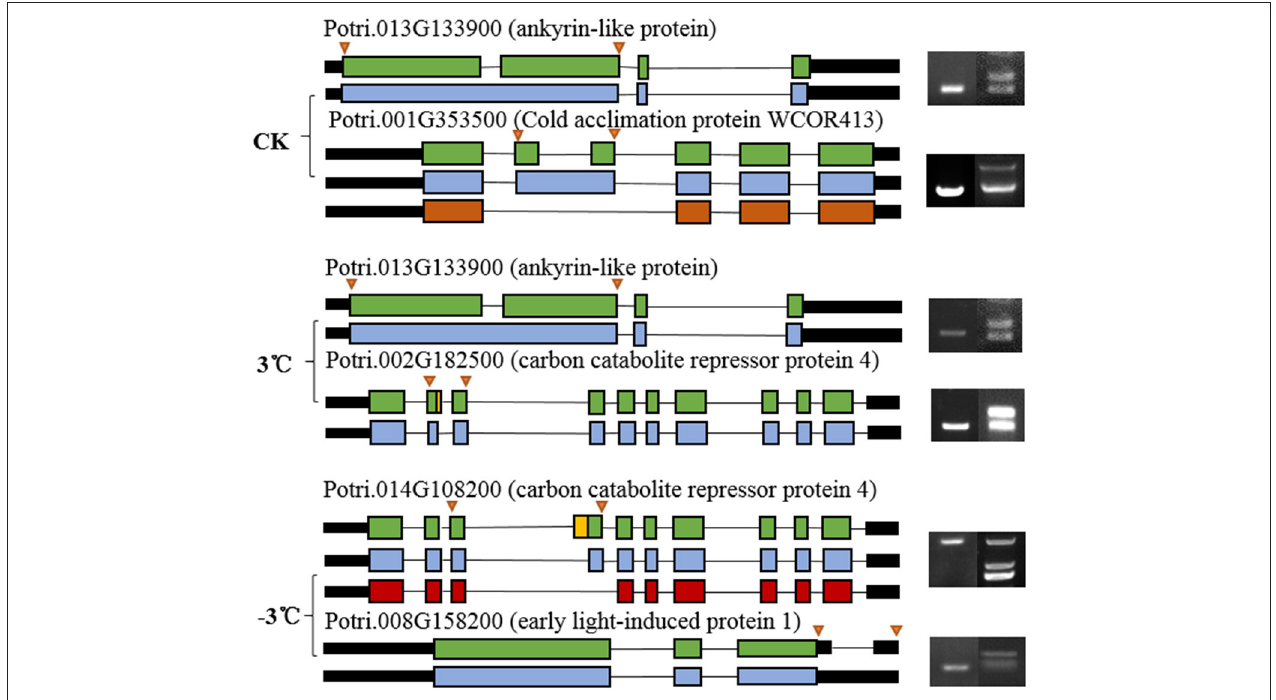
FIGURE 9 | Characteristic of randomly selected AS events and validation of randomly selected alternative splicing events detected by RNA sequencing using reverse transcription-PCR (RT-PCR). The arrow on the left side indicates the position of PCR primers used for RT-PCR. The electropherogram on the right side shows the alternatively spliced product bands in P. trichocarpa and P. ussuriensis